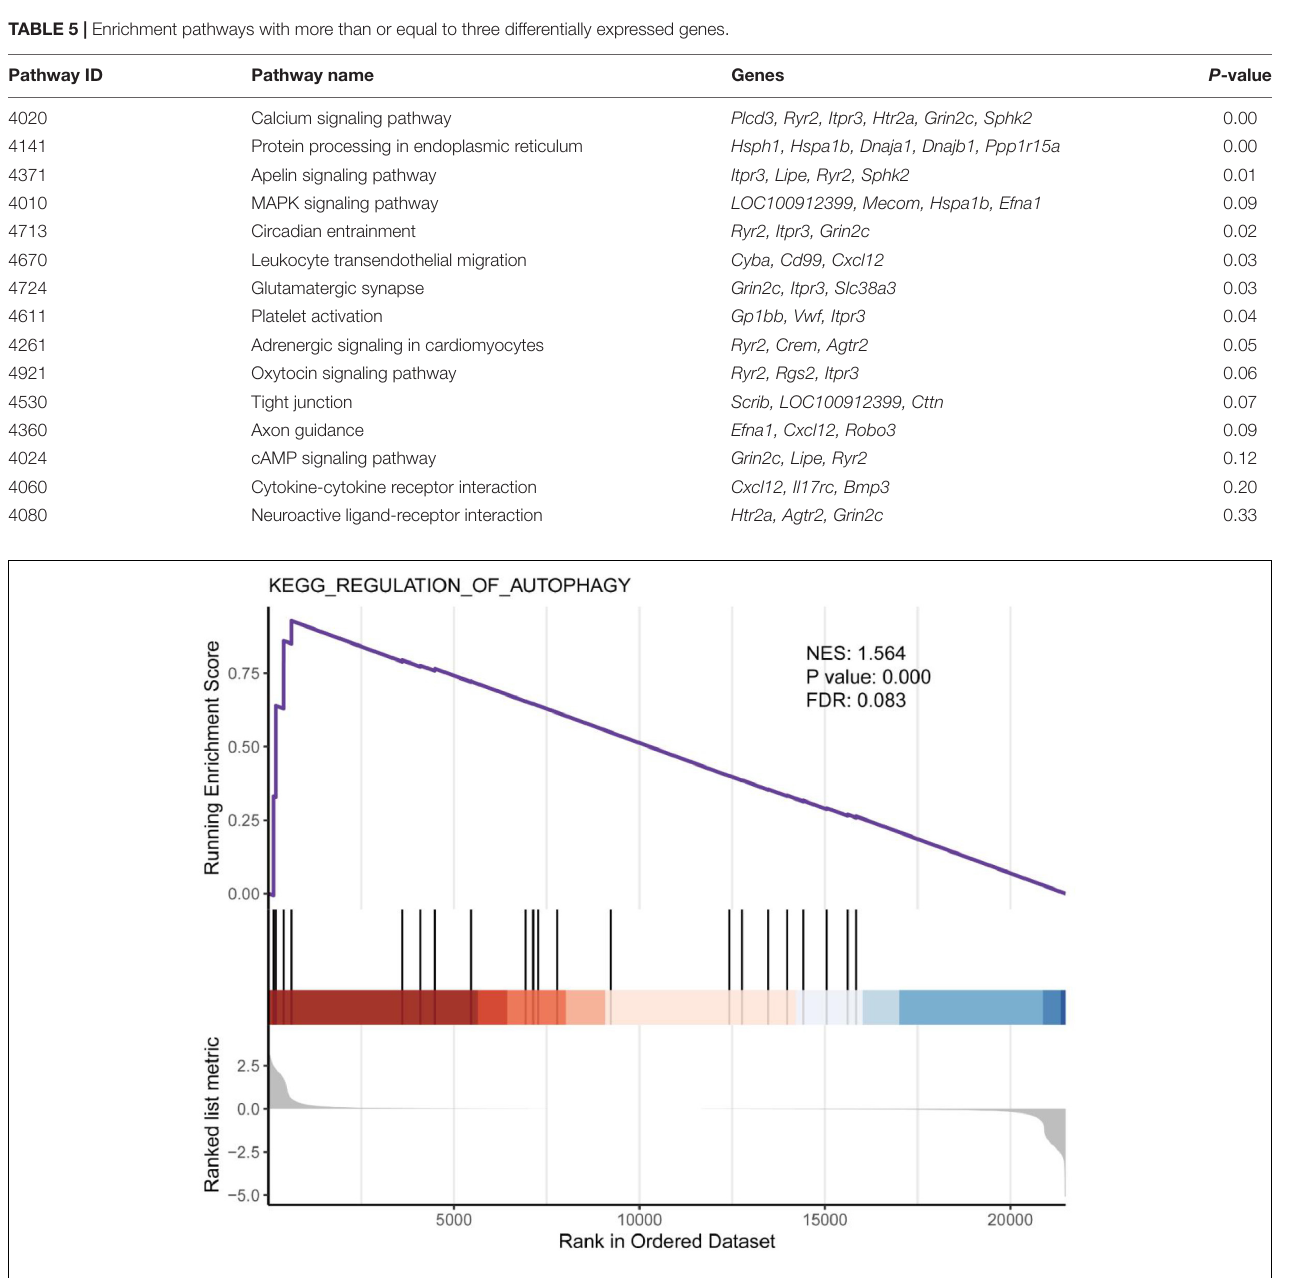
FIGURE 7 | Gene set enrichment analysis for “regulation of autophagy.” Screening with NES > 1, P < 0.05 and FDR < 0.25.